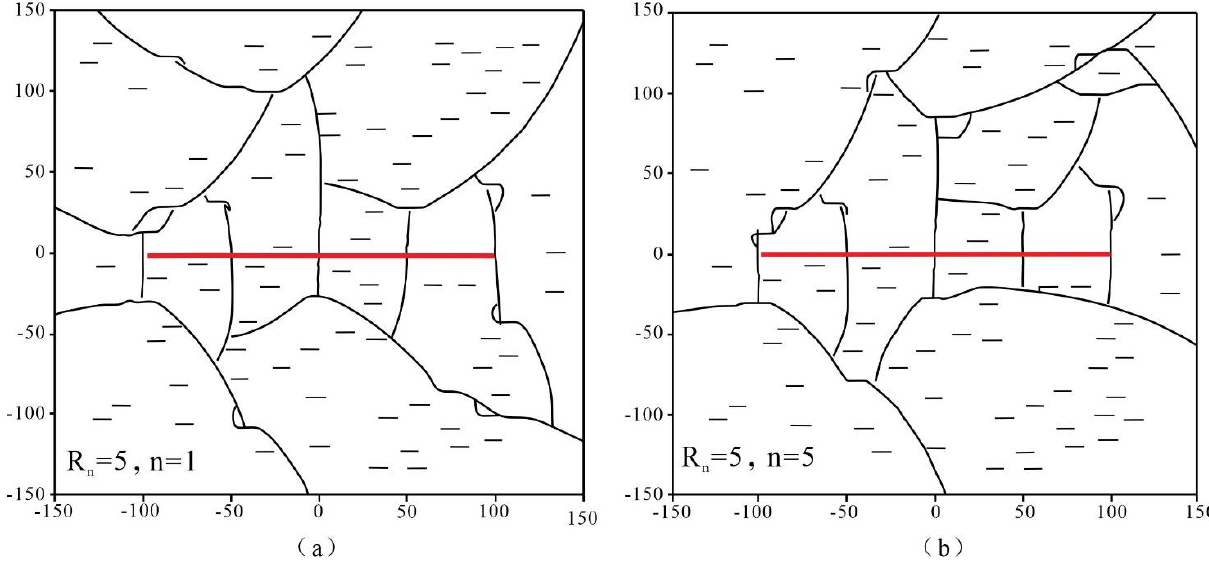
Figure 5. Two-dimensional discrete element model simulates the intersection of multi-stage fractured hydraulic fractures with natural fractures in horizontal wells, hydraulic fracture pattern for a sequential injection from left to right in the presence of 100 randomly located natural fractures with a 10 m initial length. There were 5 injection points, located at x = -100, -50, 0, 50 and 100 m and y = 0 m. The figure shows a bedding plane (map) view of the fracture geometry, and the fractures are confined to an elastic layer with a 30 m thickness. Both simulations were run with a relative net pressure of Rn = 5, but with different propagation velocity exponents — ( a ) n = 1, ( b ) n = 5 [52].